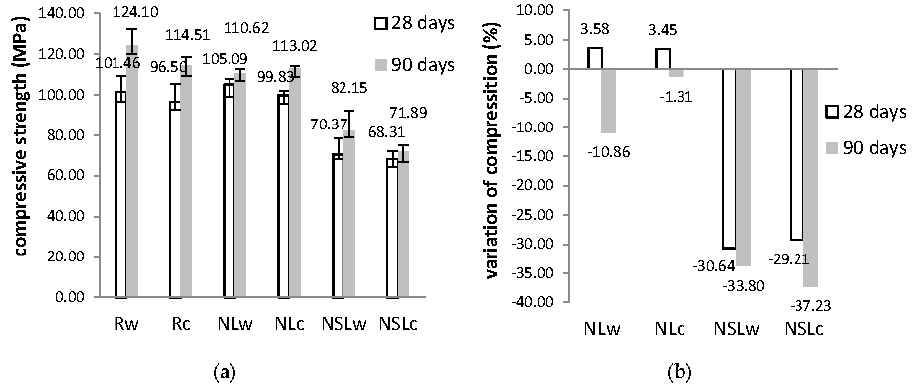
Figure 2. ( a ) Compressive strength values of the pastes at 28 and 90 days; ( b ) Compressive strength variation of nano-modified cement pastes, in respect to the